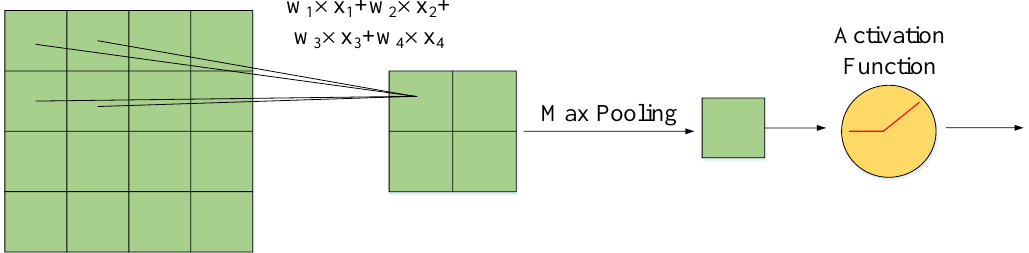
Figure 1. Basic unit of convolutional neural network. The Max Pooling is responsible for obtaining translation and rotation invariance, and the Activation Function is responsible for increasing the degree of nonlinearity.